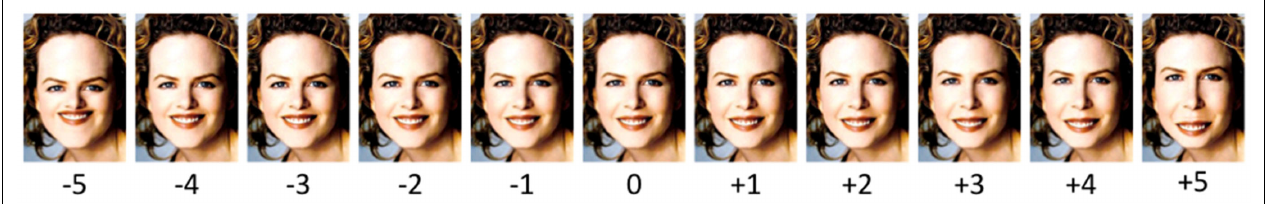
FIGURE 1 | Illustration of the stimulus continuum with the original face in the center (0), the adapting stimuli at the far ends ( − 5 and + 5), and the test stimuli in between ( − 2 and +